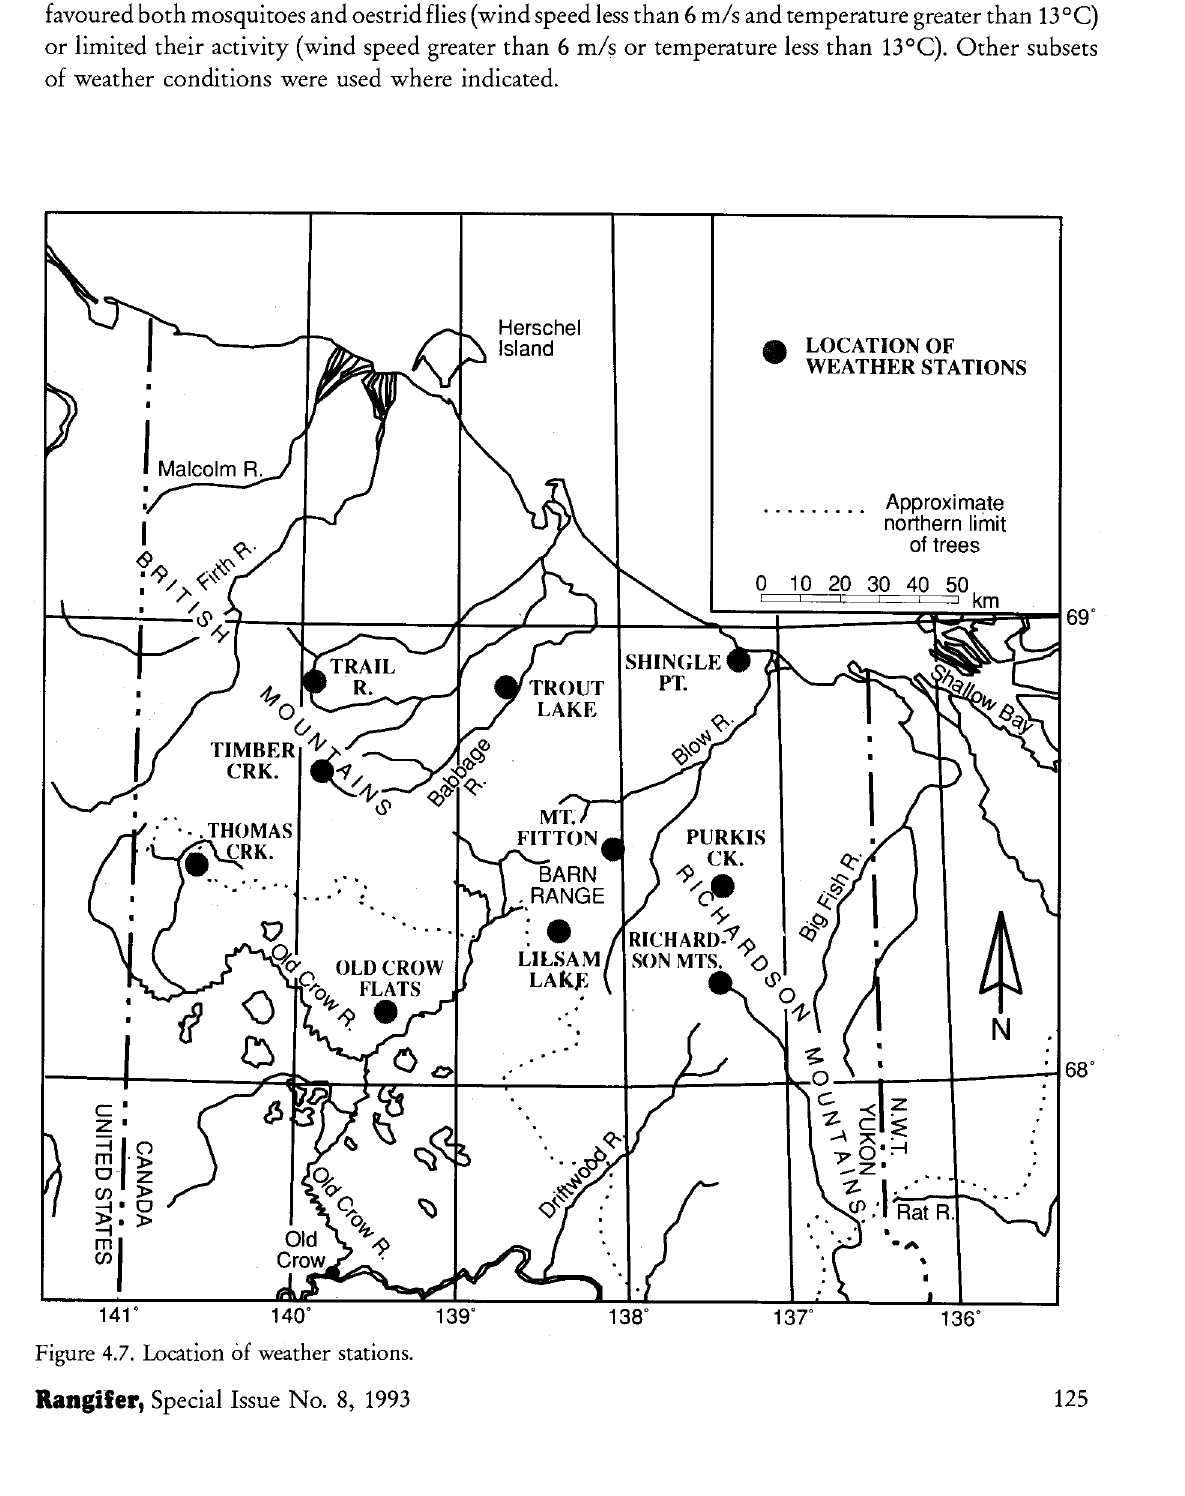
Figure 4.7. Location of weather